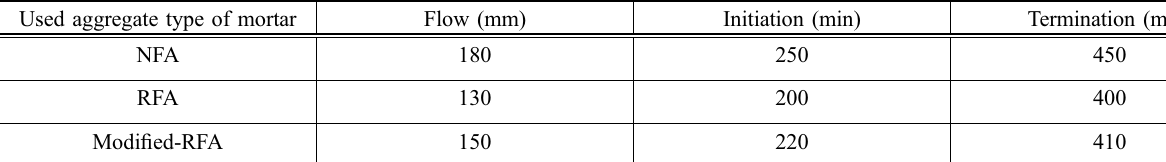
Table 11 Mortar setting times and